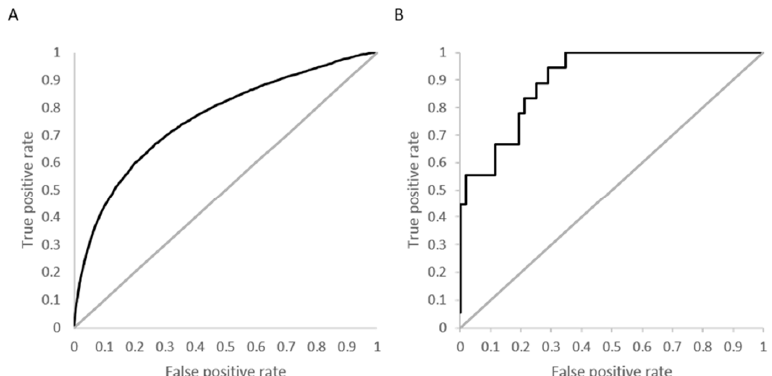
Figure 4. Performance of neural networks for kinase selectivity: ( A ) Overall receiver operator curve (ROC) computed for model developed at activity cutoff of K D = 10 µ M. ( B ) Example of ROC curve for calmodulin-dependent protein kinase-1, which has 18 active molecules at K D < 10 µ M with an area under the curve (AUC) of 0.91.